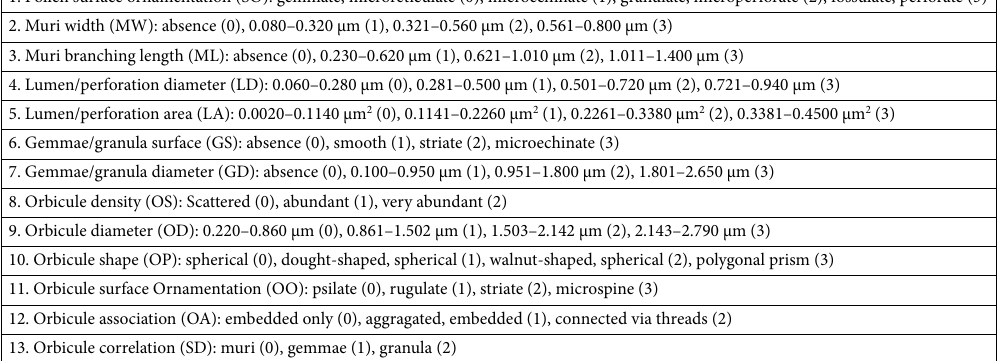
Table 3. Character list, along with their character states and the codes used in phenetic